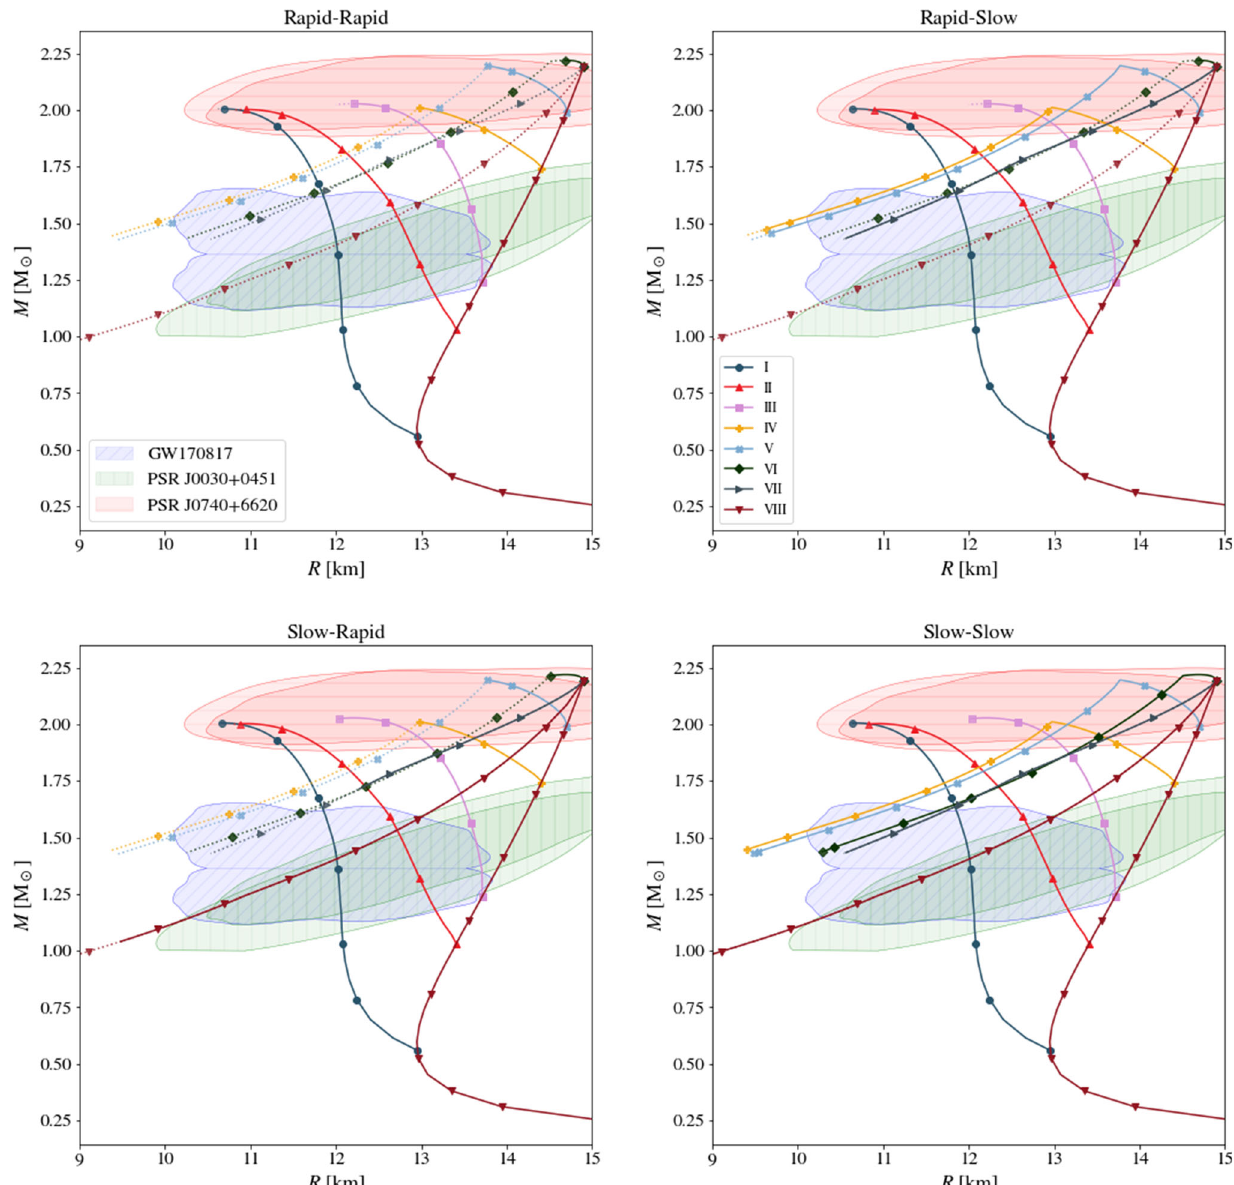
Fig. 4 Mass-radius profile of hybrid stars with sequential QCD first order phase transitions, considering different conversion rates. The dotted < 0 in the respective conversion speed lines represent the configurations that have ω 2 0